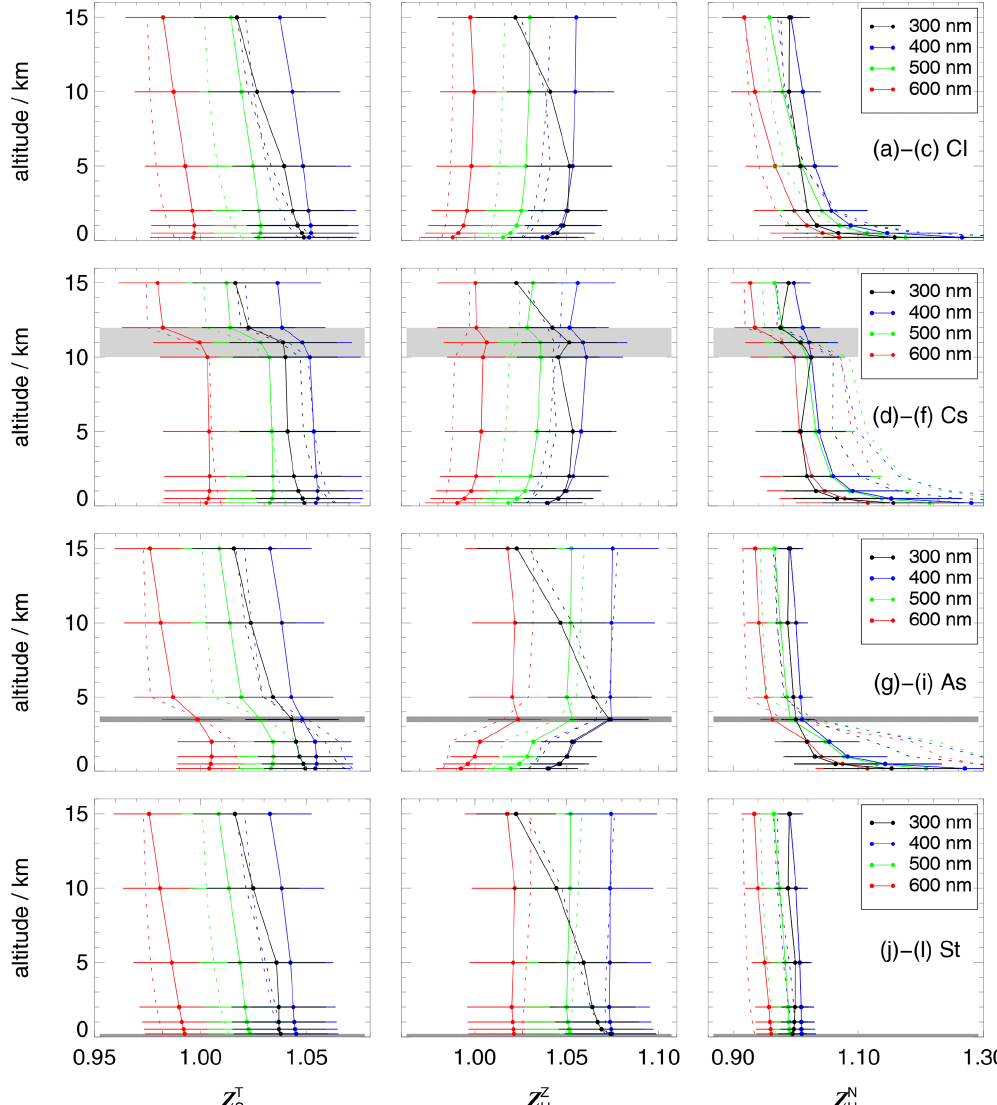
Figure 12. Altitude dependence of modelled HALO correction functions Z T flux densities for a solar zenith angle of 40 ◦ and selected wavelengths. Corrections apply to standard aerosol load, standard ground albedos and a solar heading angle γ ◦ = 90 ± 22 ◦ of the HALO configuration FLT for four cloud cases. (a–c) Clear-sky (Cl), (d–f) Cs cloud layer, (g–i) As cloud layer and (j–l) St cloud layer. Cloud layers are indicated by grey shaded areas. Error bars include the effects of ± 2 . 5 ◦ attitude variations. Dashed lines show results assuming hemispherical-isotropic distributions of downward and upward diffuse spectral